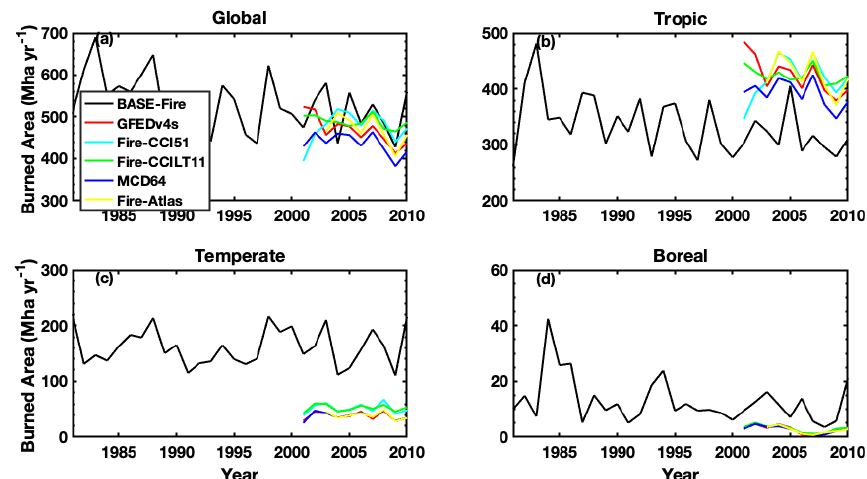
Figure 2. ELMv1 process-based model (BASE-Fire) simulated and five observationally inferred burned area products (Table S1) at (a) global